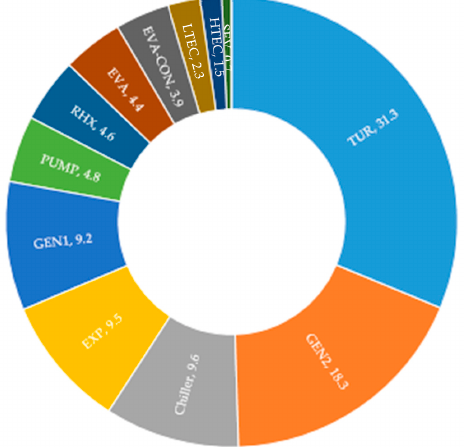
Figure 9. Percentage distribution of fixed capital investment for the poly-generation system units. Chiller = electricity-driven vapor compression cycle (VCC); EVA = evaporator; EVA-CON = evaporator-condenser; EXP = LNG expander; GEN = electric generator; HTREC = high temperature recuperator; LTREC = low-temperature recuperator; PUMP = LNG pump; RHX = refrigeration heat exchanger; SEP = vapor-liquid separator; SEV = solution expansion valve; SP = solution pump; TUR = KC turbine. Values are percentage of total fixed capital investment for each unit. Table 9. Monetary and environmental analysis results for the poly-generation system per kg/s LNG .